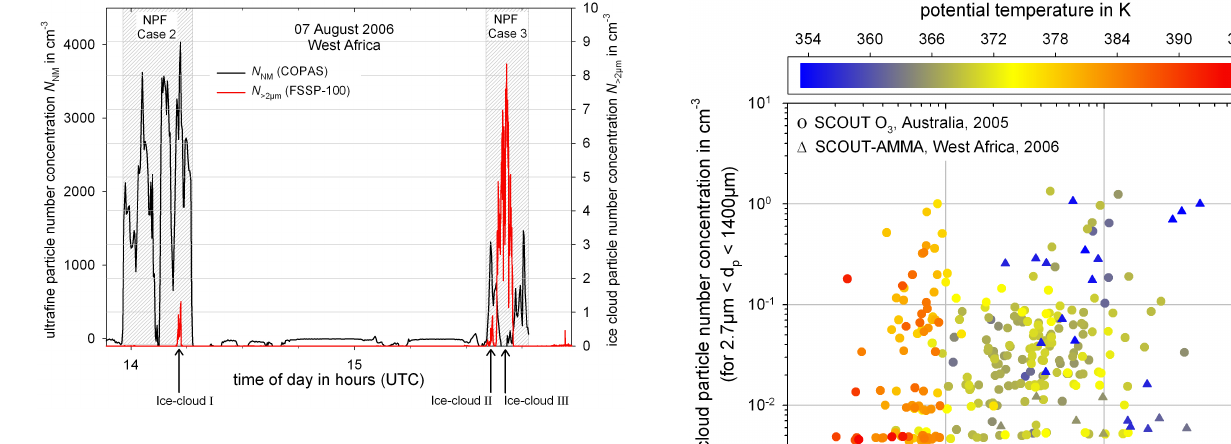
Fig. 11. Close-up of the time series of measured number concentra- tion of nucleation mode particles N NM (COPAS, black line) and of ice cloud particles N > 2 µ m (FSSP-100, red line) of the M-55 Geophysica flight on 7 August 2006 over West Africa. Nucle- ation mode particles are present at 170–1000cm − 3 in ice clouds (1.3–0.9cm − 3 , ice cloud I and II). At ice particle concentrations above 2cm − 3 NPF mode particles were not detected (Ice-cloud III).